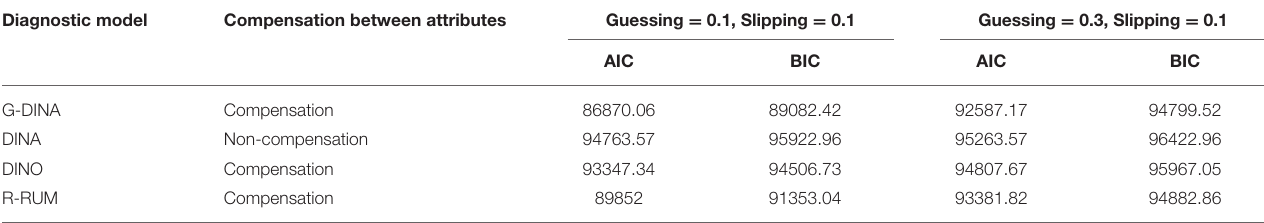
TABLE 7 | Relative fitting indexes of the different cognitive diagnosis models.